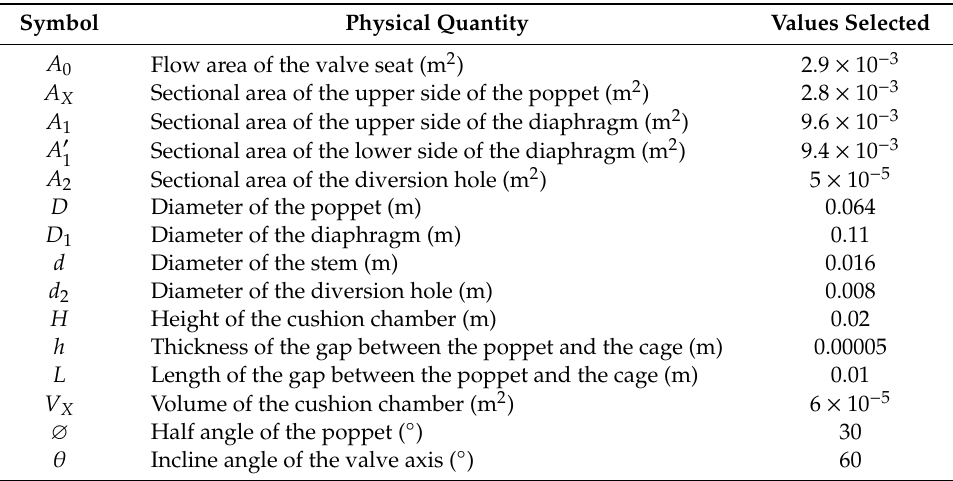
Table 1. Main structure dimensions of the